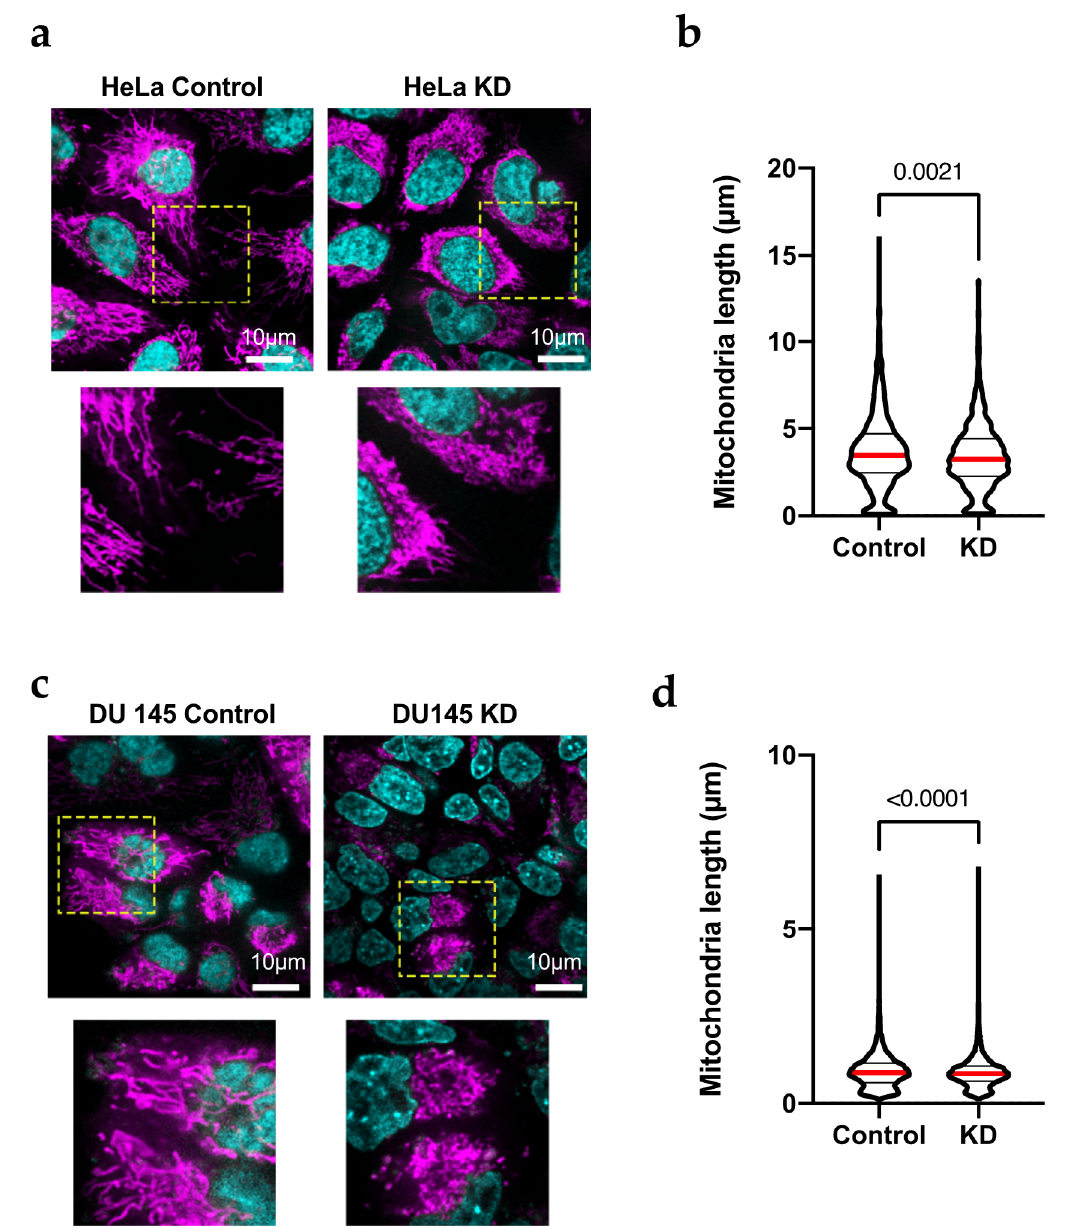
Figure 2. HeLa KD cells show mitochondrial fragmentation. ( a , c ) Confocal images of HeLa ( a ) and Du145 ( c ) cells transfected with siRNA against Kv10.1 for 48 h, stained with Mitotracker Red (magenta, mitochondria) and Hoechst 33342 (czan, nuclei) and analyzed by confocal microscopy. Mitochondria show fragmentation in KD cells while control cells show elongated mitochondria. The are inside the yellow square is shown magnified below. ( b , d ) The length of individual mitochondria in HeLa and Du145 cells was determined by filament tracking analysis of 3-dimentional reconstructions using Imaris software. In both cases, KD cells showed shorter mitochondria, In b and d, the median value is indicated by a red line and the number indicates the value of p obtained by non-parametric Mann-Whitney test since the limit in resolution renders the distributions not normal.